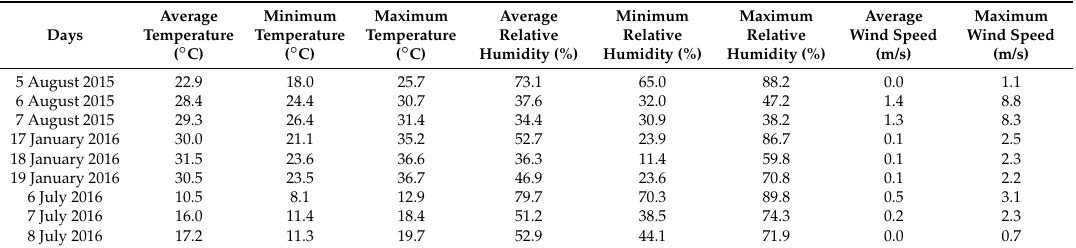
Table 2. Average values of climatic attributes collected during the periods of